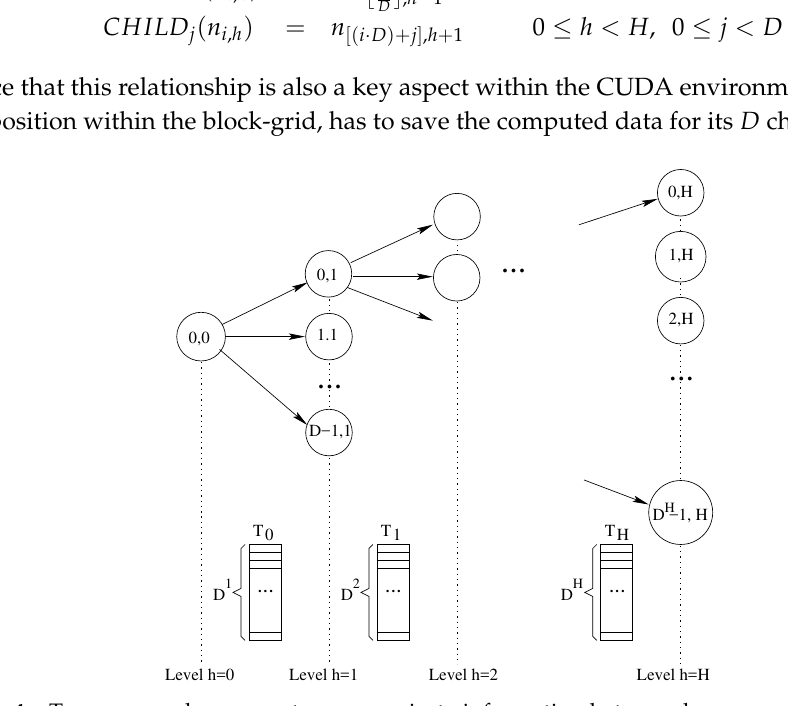
Figure 4. Tree, reserved memory to communicate information between layers, and mathematical dependency among tree nodes (i.e., concurrent threads). The tree has a degree equal to D and a height equal to H . At each level h , we use a texture array T h containing D h elements, and implemented as a 2D matrix to exploit 2D caching